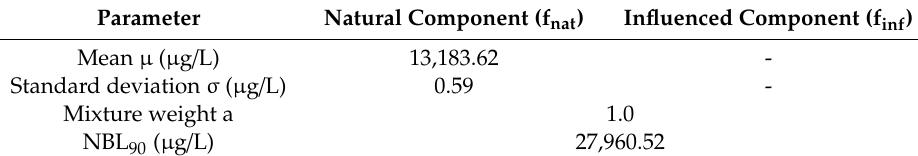
Table 2. GuEstNBL output: Results of the guided estimation procedure for iron dataset.